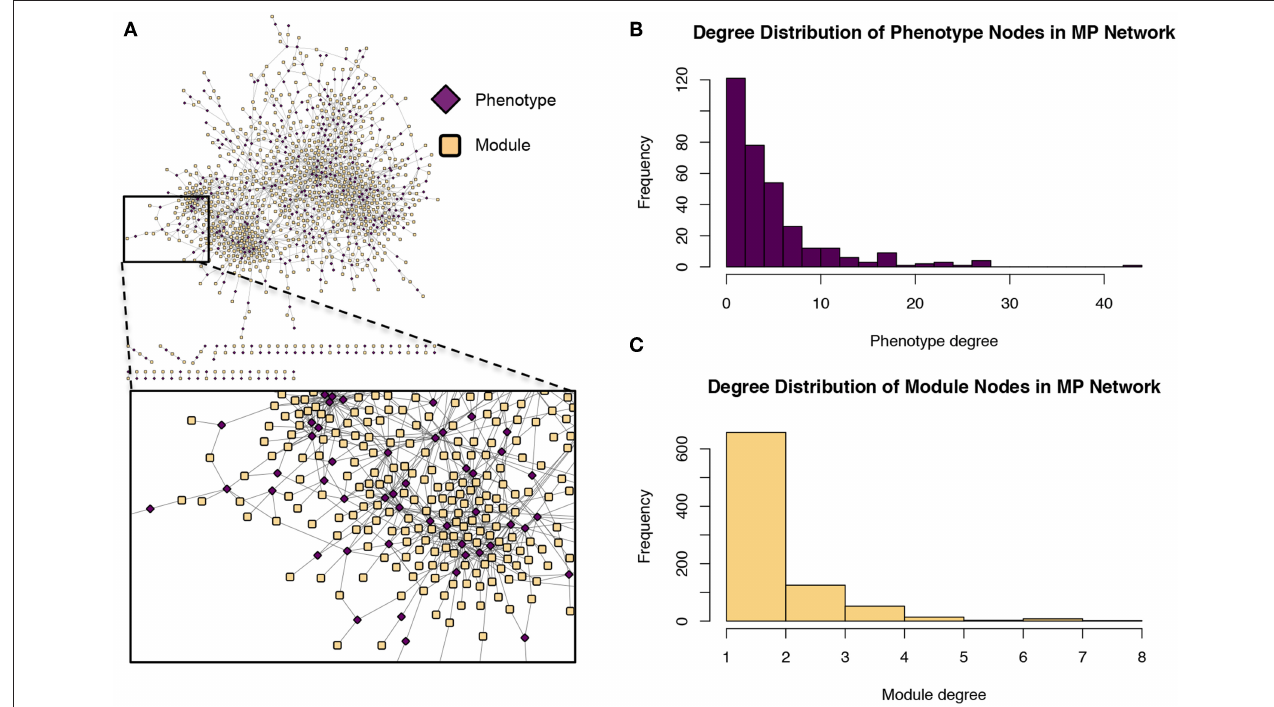
FIGURE 9 | Module-phenotype ( MP ) network. (A) The MP network. Yellow nodes represent association modules and pink nodes represent phenotypes. A module node is connected to a phenotype node if the phenotype is associated with all SNPs within the module and is thus considered a driving phenotype of the module. (B) Degree distribution of the phenotype (pink) nodes in the MP network. (C) Degree distribution of the module (yellow) nodes in the MP